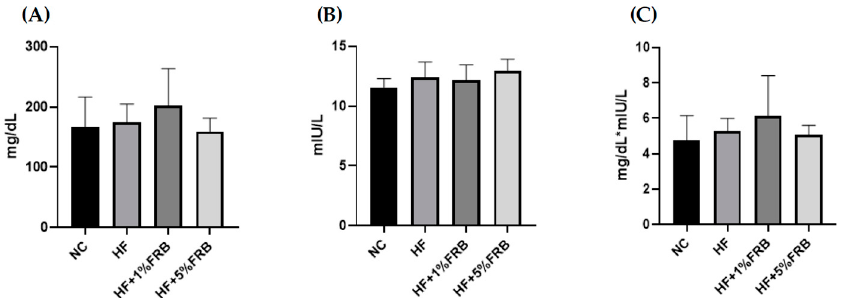
Figure 7. Effects of the water extract of fermented rice bran (FRB) on the insulin resistance analysis in aged rats with high-fat (HF) diet feeding. ( A ) Fasting blood glucose level, ( B ) fasting plasma insulin level, and ( C ) homeostasis model assessment of the insulin resistance index (HOMA-IRI). Values are presented as the mean ± standard deviation ( n = 6). Significance between the normal control (NC) and HF groups was determined using Student’s t -test. In the HF diet-fed groups, significant differences between groups were determined by a one-way ANOVA with Fisher‘s post hoc test.